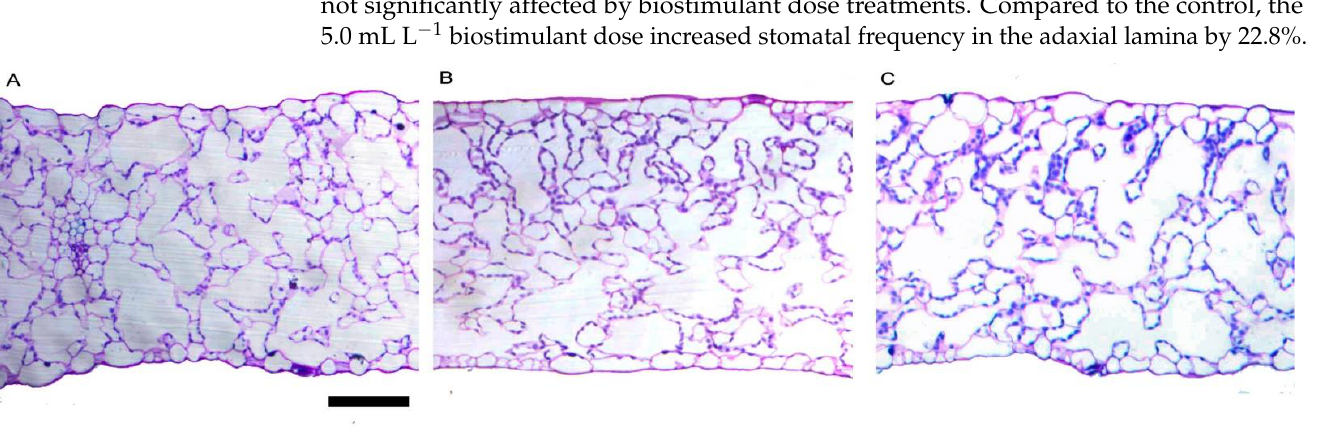
Figure 3. Light microscopy views of cross sections of leaf lamina of lettuce treated with the different doses of biostimulants: ( A ), control; ( B ), 2.5 mL L – 1 ; ( C ), 5.0 mL L – 1 . Images are all at the same magnification. Bar = 100 µm.